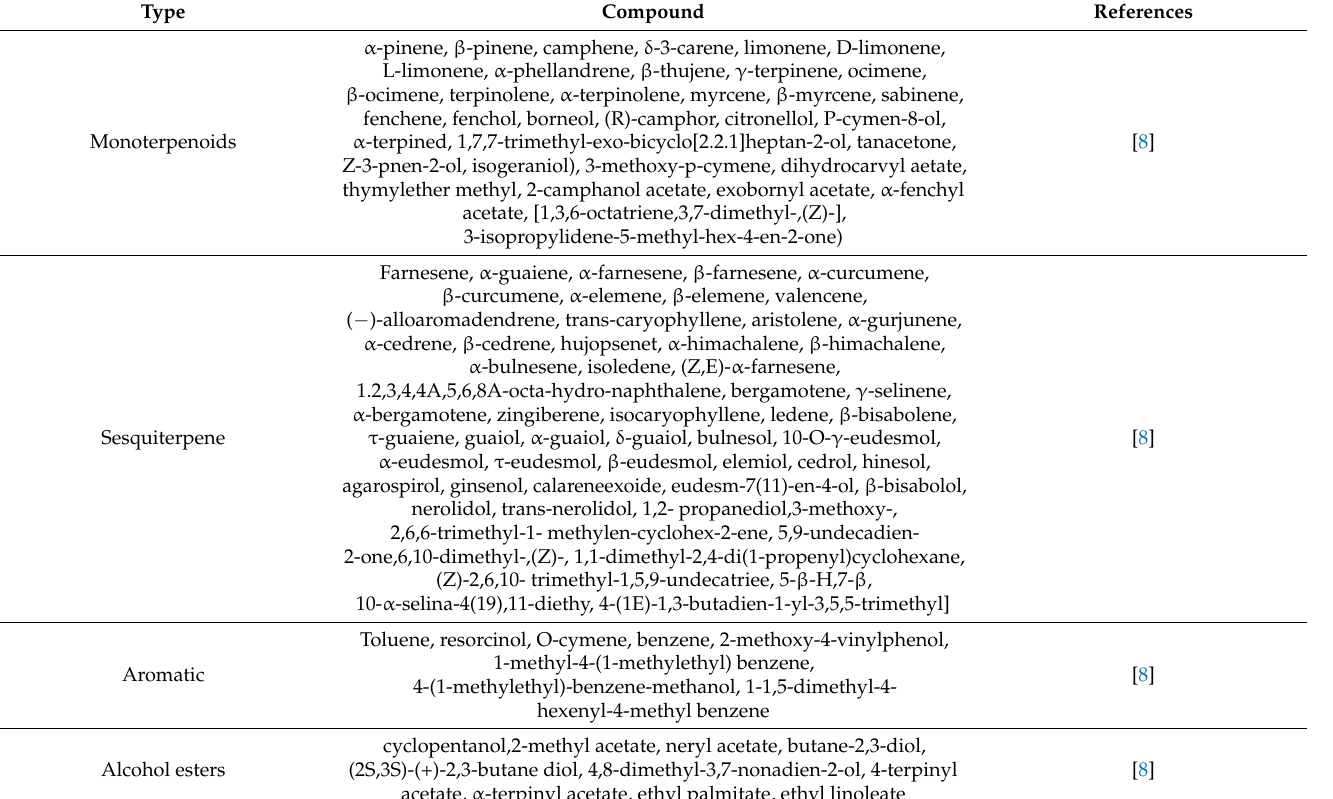
Table 2. Main chemical compositions in volatile oil of F.